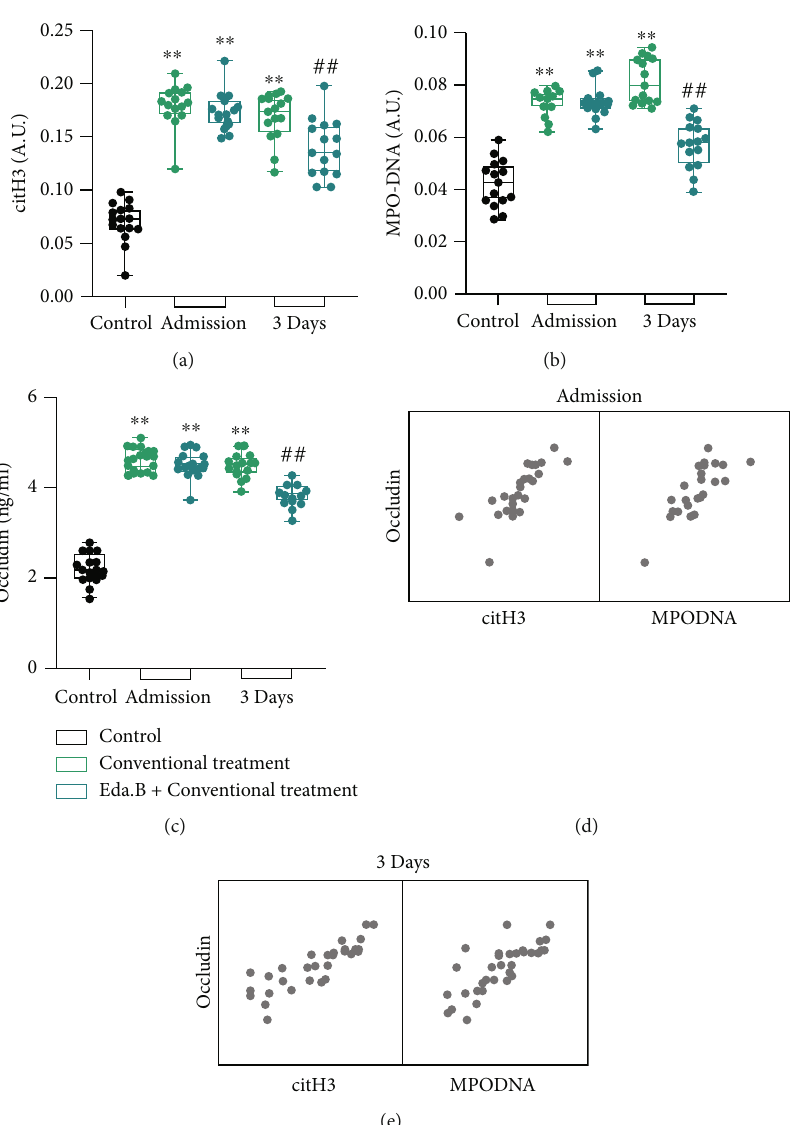
Figure 1: Levels of NET markers and occludin level in patients ’ serum sample. (a – c) citH3 and MPO-DNA complex are expressed in arbitrary units (A.U.), and the occludin concentration is expressed as ng/ml. (d, e) Matrix scatter plot of correlation between citH3, MPO-DNA complex, and occludin in stroke patients. ∗∗ P < 0 : 01 (conventional treatment group or Eda.B group at admission vs. control group) and ## P < 0 : 01 (Eda.B group vs. conventional treatment), n = 15 in each group. Table 1: Multiple linear regression analysis of citH3 and MPO-DNA a ff ecting serum occludin levels in AIS patients at admission. Unstandardized coe ffi